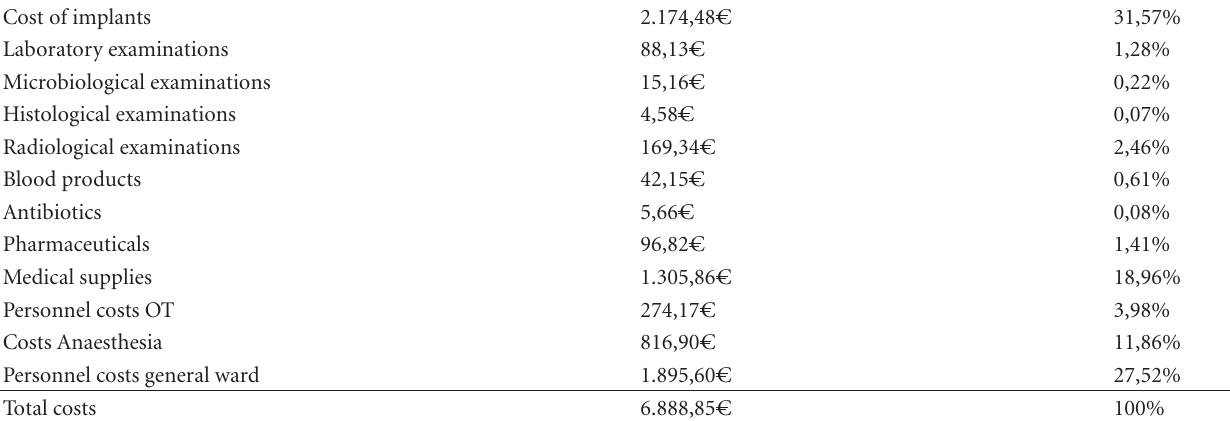
Table 2: Mean absolute and percentage costs of relevant positions case control group (noninfected primary TKA).